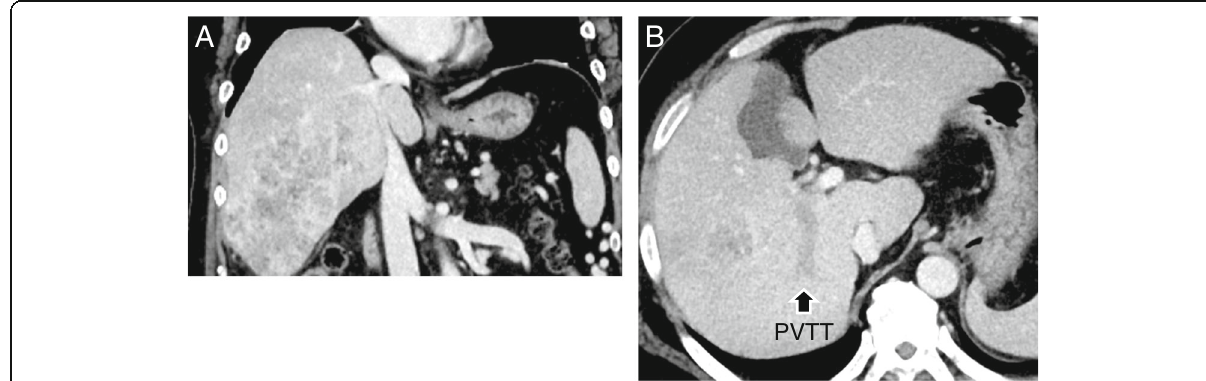
Fig. 1 Dynamic CT scan on admission to our hospital. a Coronal view (portal phase). b Axial view (portal phase). Dynamic CT showed a large diffuse- type HCC with a PVTT in the right posterior branch of the portal vein